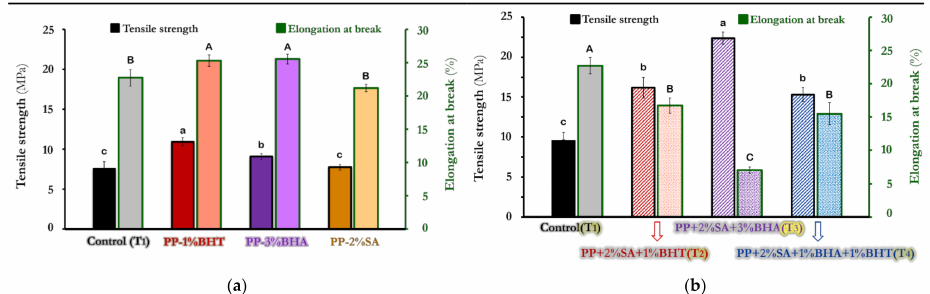
Figure 2. Tensile strength (TS) and elongation at break (E b ) variations of pure polypropylene (PP) and different active composite films incorporating either single ( a ) or a combination ( b ) of antioxidants/antimicrobial substances. Data are mean of triplicate measurements. Error bars indicate SD values. Different small and capital letters show a significant ( p < 0.05) difference between means for TS and E b parameters,